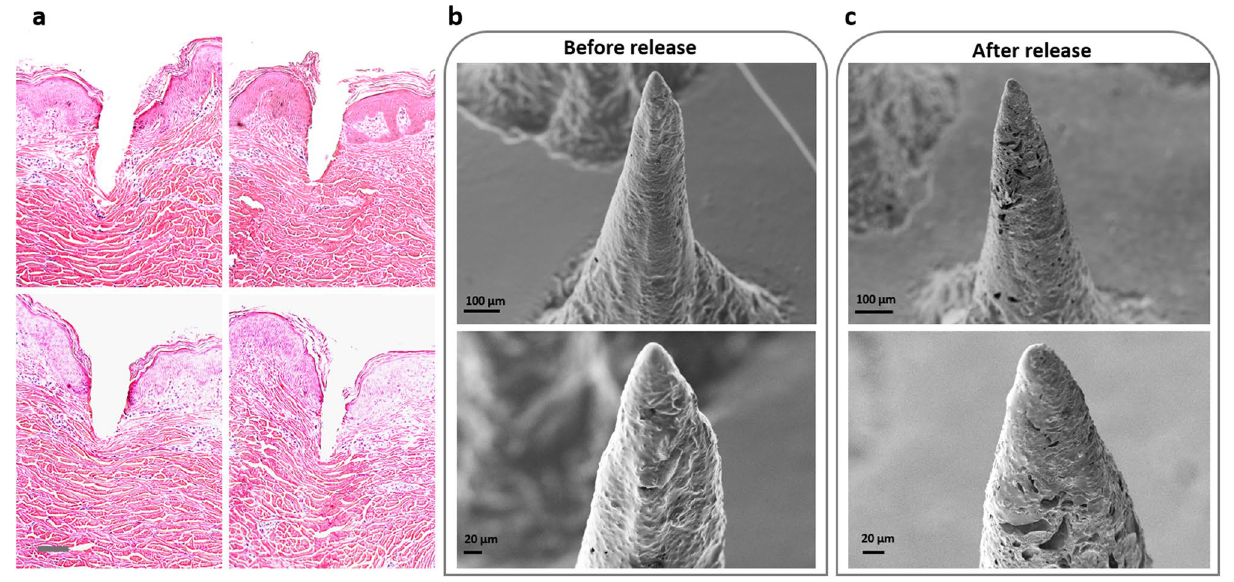
Figure 5. ( a ) Histology examination of the microneedles, scale bar 100 µm, ( b ) SEM images of resin/drug before release, ( c ) SEM images of resin/drug after release.